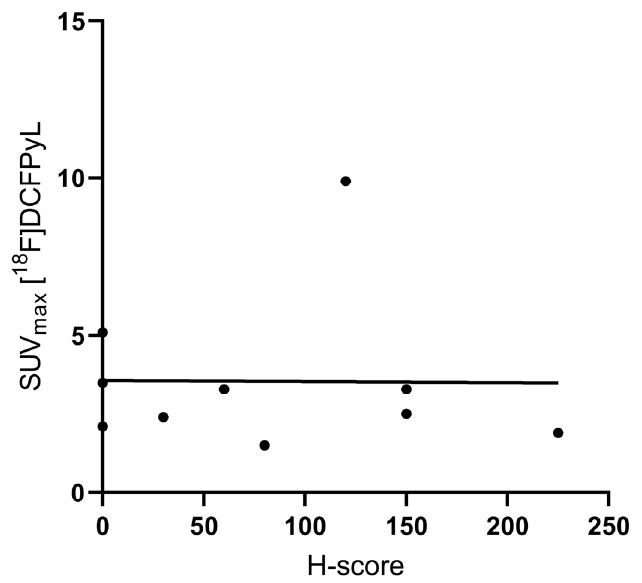
Cancers 2022 , 14 , x FOR PEER REVIEW 11 of 15 Figure 5. Scatterplot of [ 18 F]DCFPyL SUV max values with associated H scores. Abbreviations: SUV max , maximal standardized uptake value.